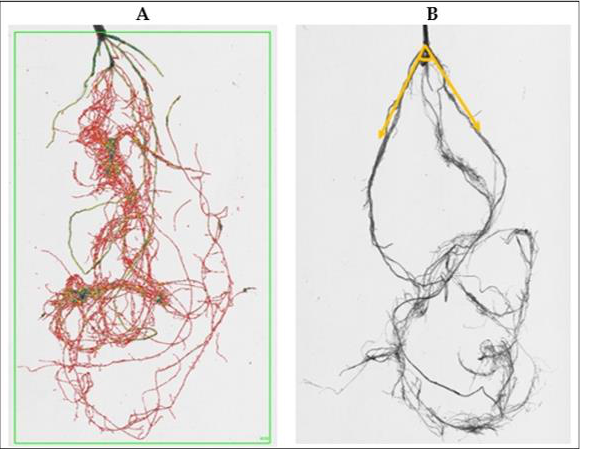
Figure 6. The measurements of morphological root traits ( A ) using Win-RHIZO system and root angle ( B ) using ImageJ ( ◦ ).